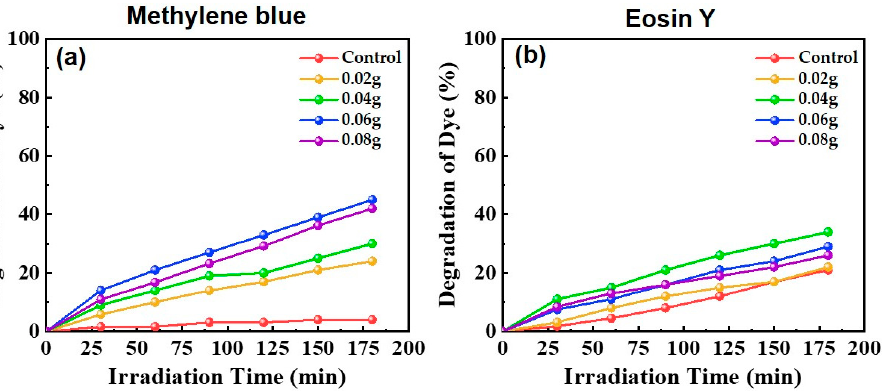
Figure 5. Absorption spectral pattern of ( a ) control and EY during photocatalytic degradation process in the presence of LC-ZnO/OF under visible light irradiation ( b – e ).